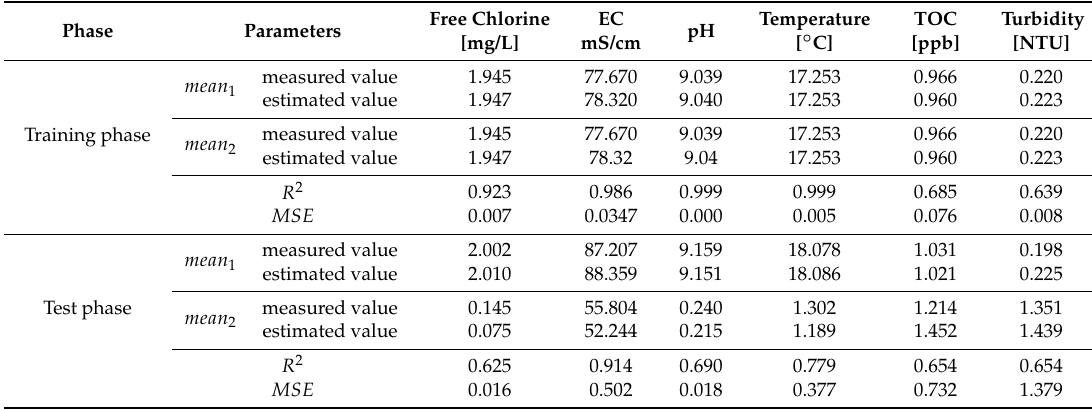
Table 5. Training results and test results with BP